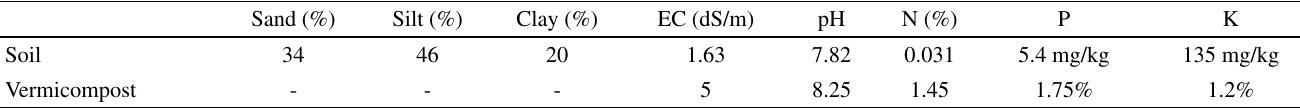
Table 1 - Physical and chemical properties of soil and vermicompost used for the experiment Sand